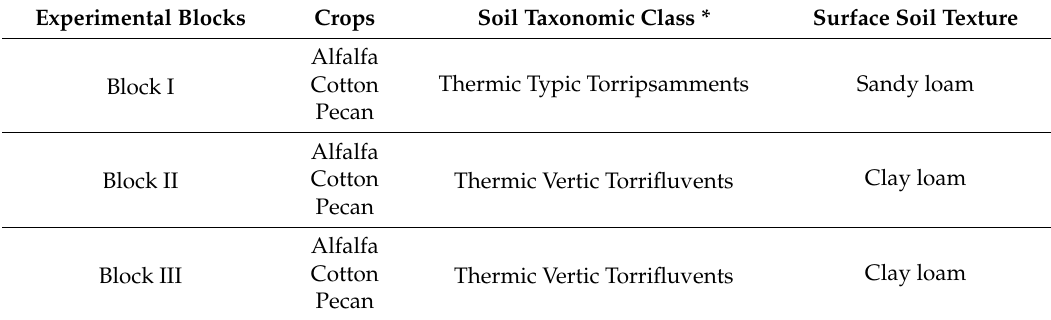
Table 1. Crop management practices, soil taxonomic class, and soil texture of the sampled fields at the New Mexico State University (NMSU) Leyendecker Plant Science Center in southern New Mexico, USA. Experimental Blocks Crops Soil Taxonomic Class * Surface Soil Texture Alfalfa Thermic Typic Torripsamments Block I Pecan